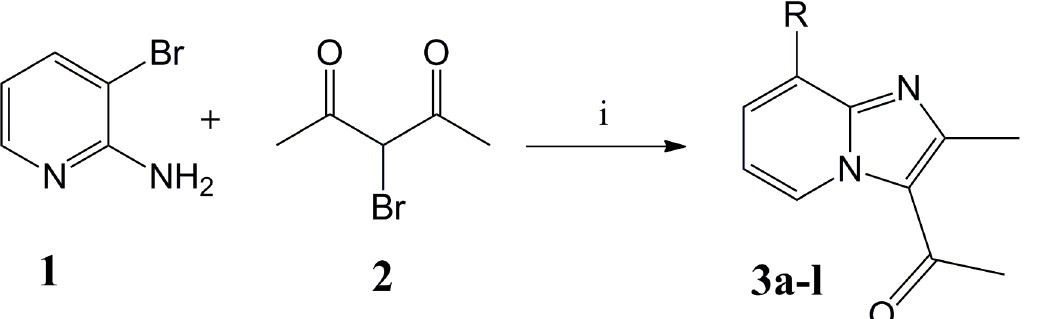
Fig 2. Synthesis of